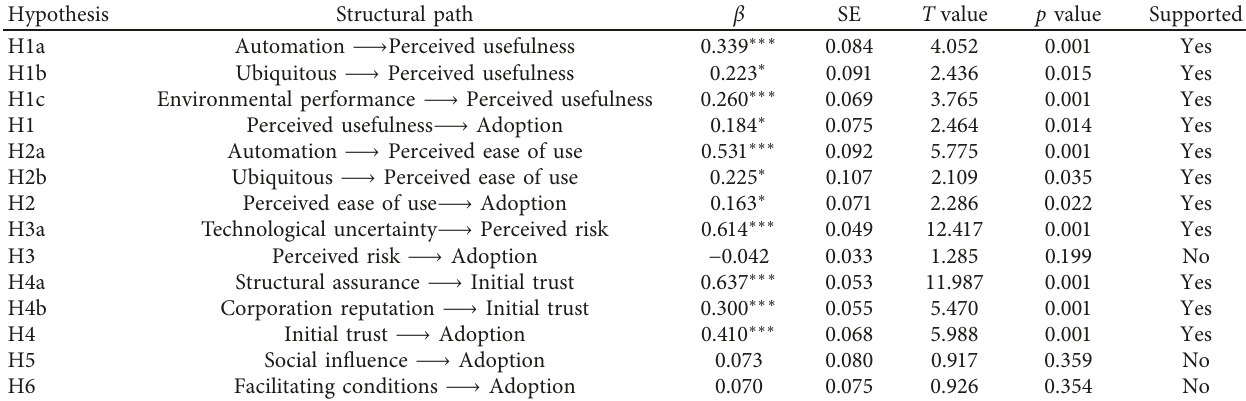
Table 7: Summary of the hypothesis test.